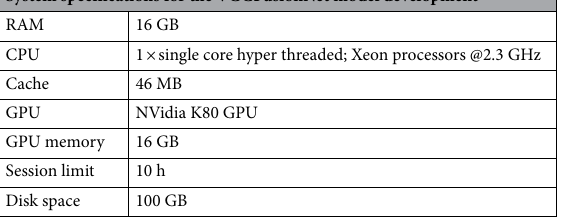
Table 1. Specifications of the system.